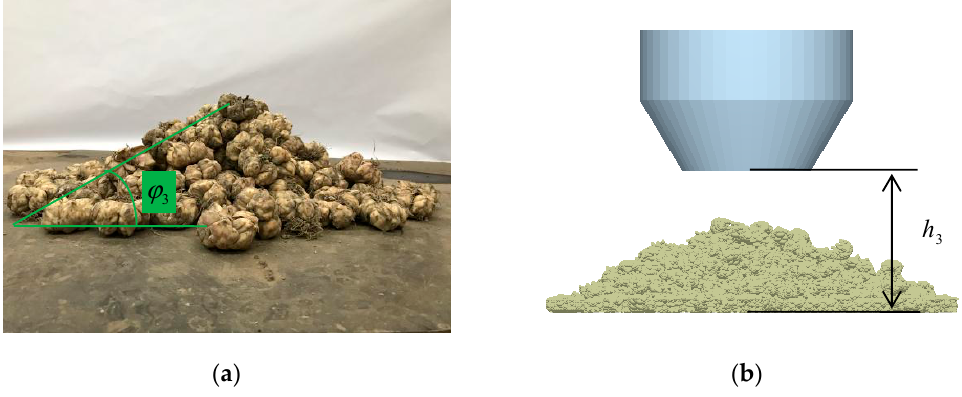
Figure 9. Stacking experiment of Lily bulb in Q235 steel plate. ( a ) Bench test; ( b ) Simulation test.